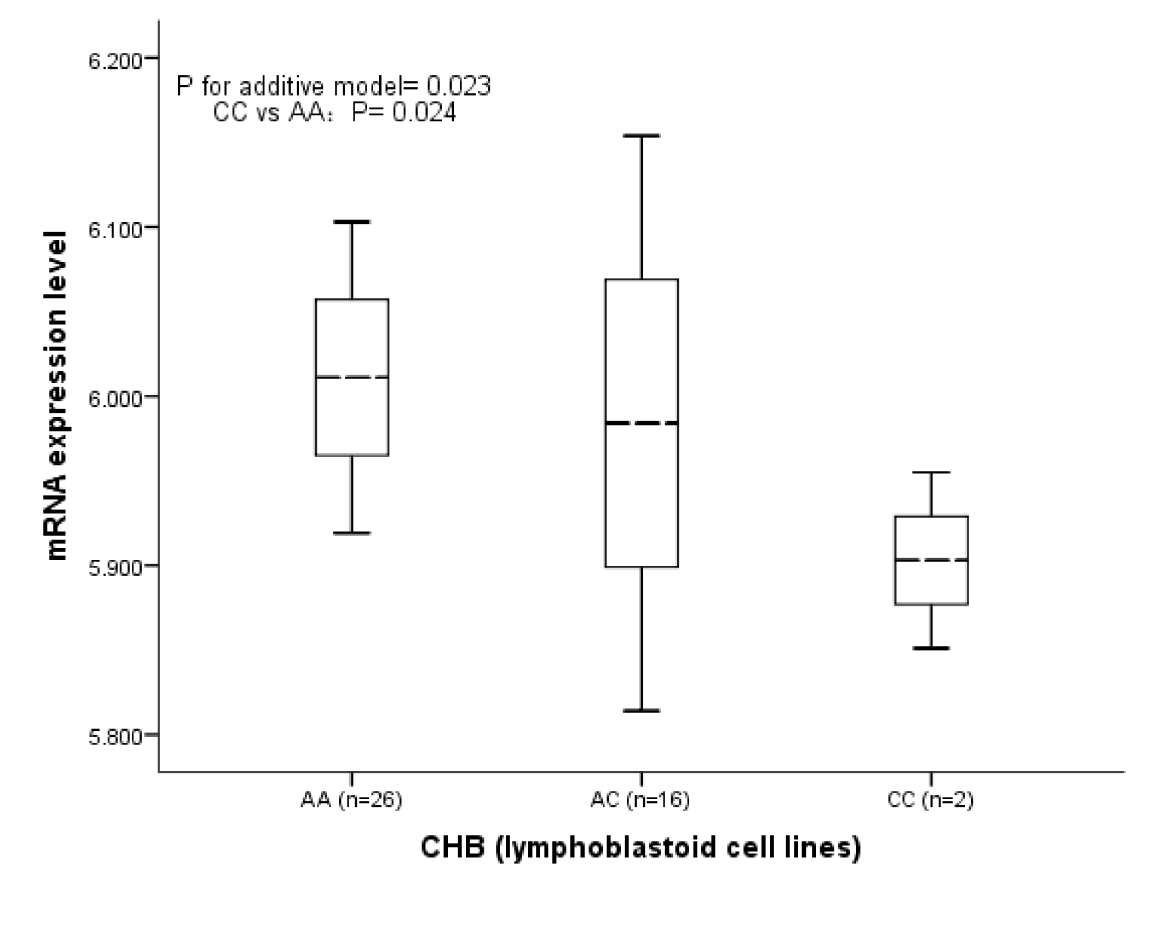
Figure 1. The mRNA expression level of YAP1 gene in unrelated